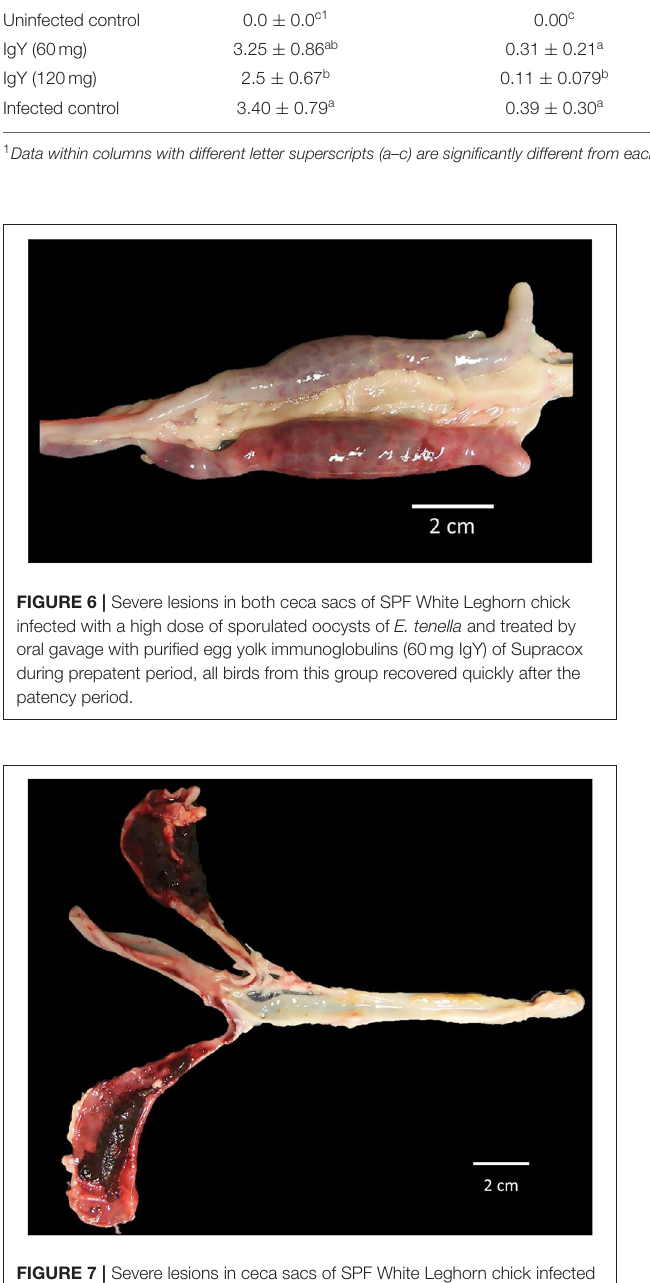
FIGURE 7 | Severe lesions in ceca sacs of SPF White Leghorn chick infected with a high dose of sporulated oocysts of E. tenella , this bird did not receive any treatment of immunotherapy based in purified egg yolk immunoglobulins (IgY) of Supracox during prepatent period, at least 25% of these birds died through this